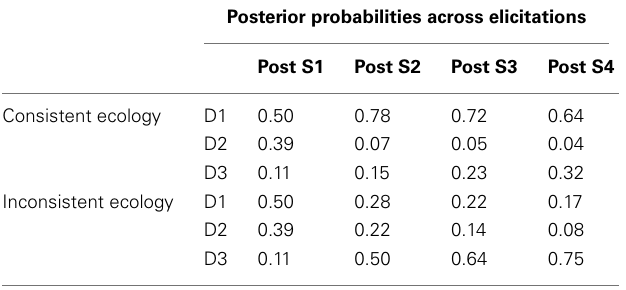
Table 4 | Bayesian posterior probabilities as further symptoms are acquired within each ecology of Experiment